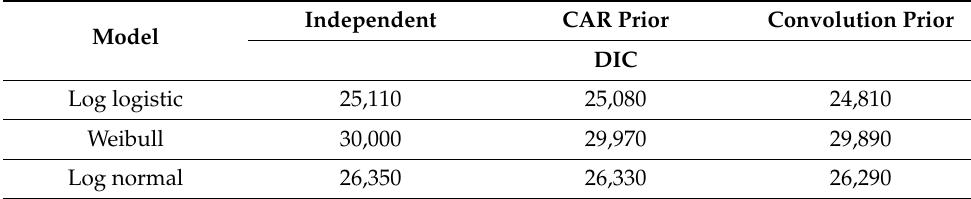
Table 2. A comparison of goodness-of-fit (DIC values) between the three cases of the AFT spatial